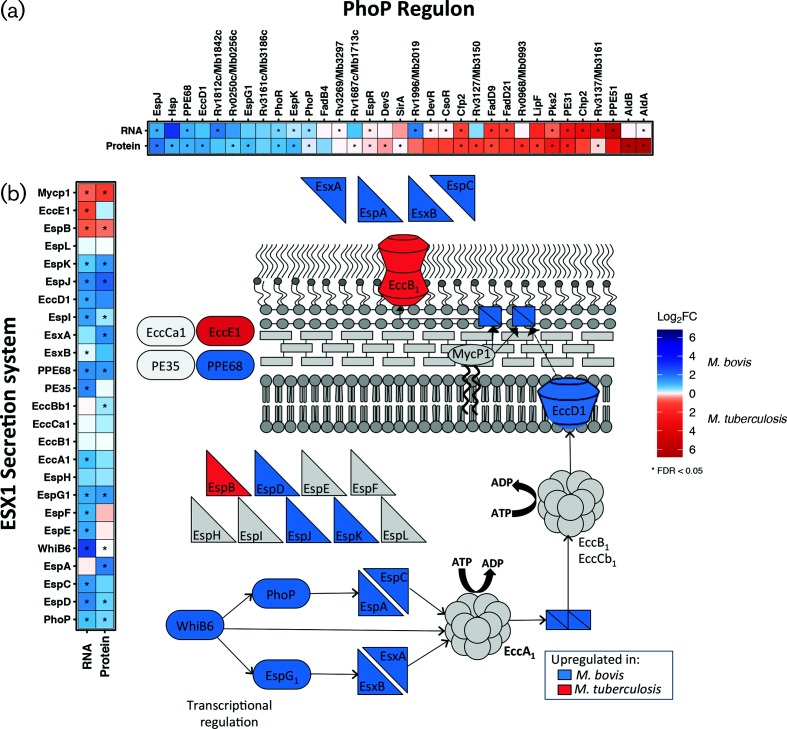
The DE genes [|log2FC|>1, FDR<0.05 (‘*’)] belonging to (a) the PhoP regulon and (b) the ESX-1 secretion system that are upregulated in M. bovis AF2122/97 (blue) or M. tuberculosis H37Rv (red). Inset: a representation of the ESX-1 secretion system pathway of M. tuberculosis coloured according to the upregulation of the associated gene in M. bovis AF2122/97 (blue) or M. tuberculosis H37Rv (red).